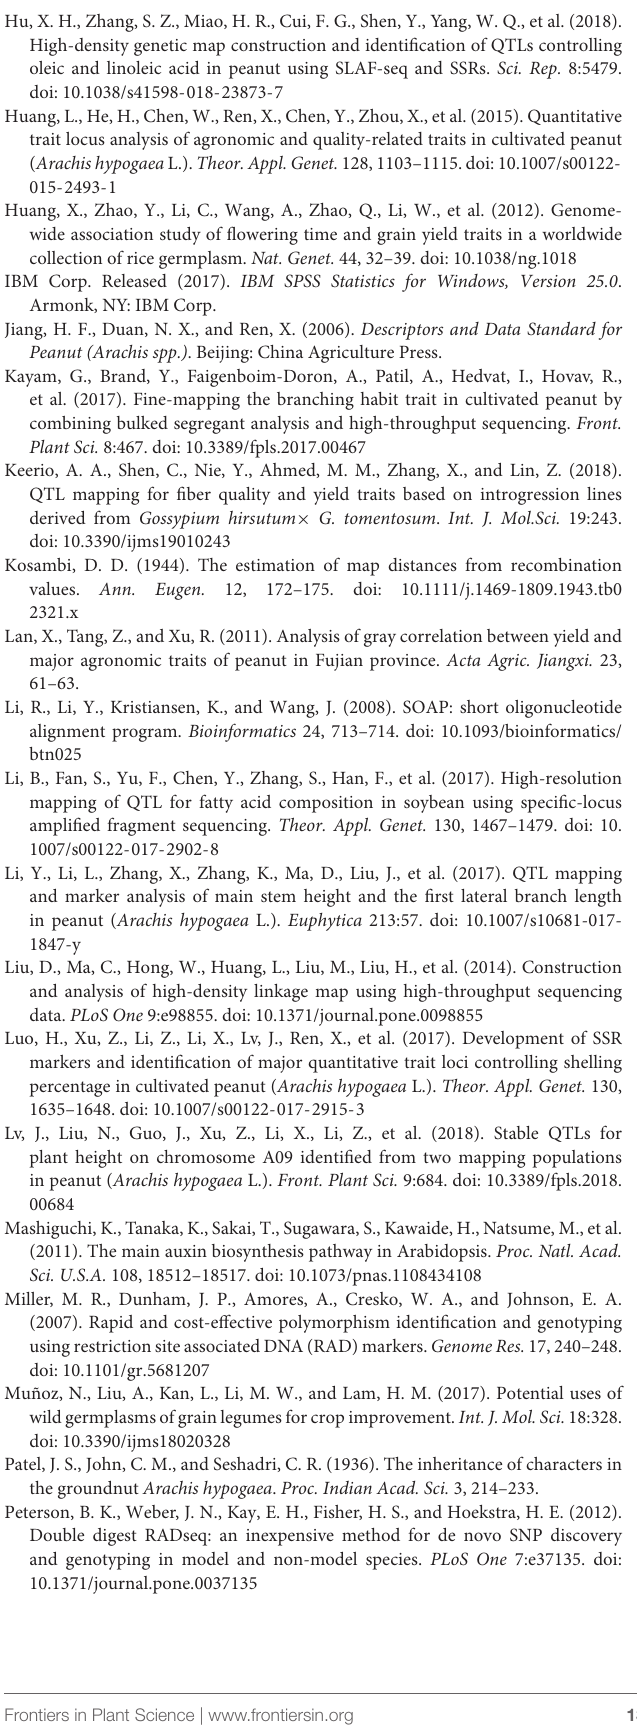
Frontiers in Plant Science |